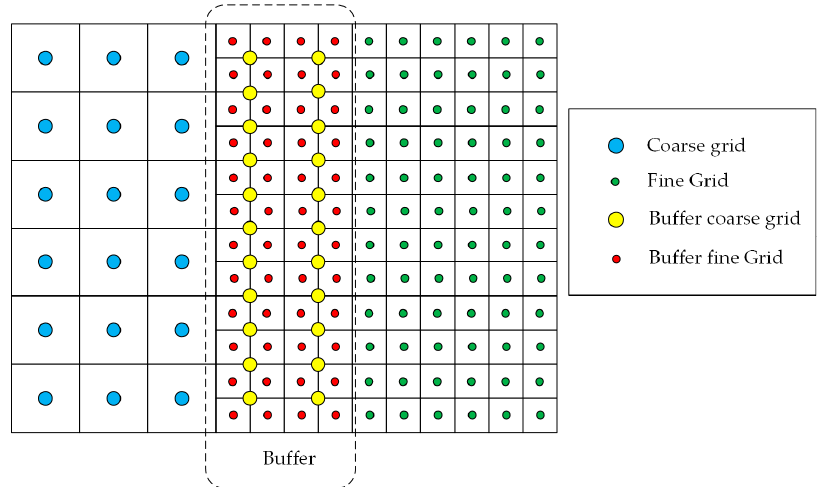
Figure 10. Buffer area for coarse and fine grid. The blue and green dots in Figure 10 are the center points of the coarse grids and the fine grids, respectively. The grid points in the dotted lines are the grid points of the buffer. The yellow dots are the center points of the coarse grids in the buffer and the red dots are the center points of the fine grids in the buffer. In Figure 10, the grid points in the buffer are recorded in two columns of coarse grid points (yellow) and four columns of fine grid points (red) at the interface of coarse grids and fine